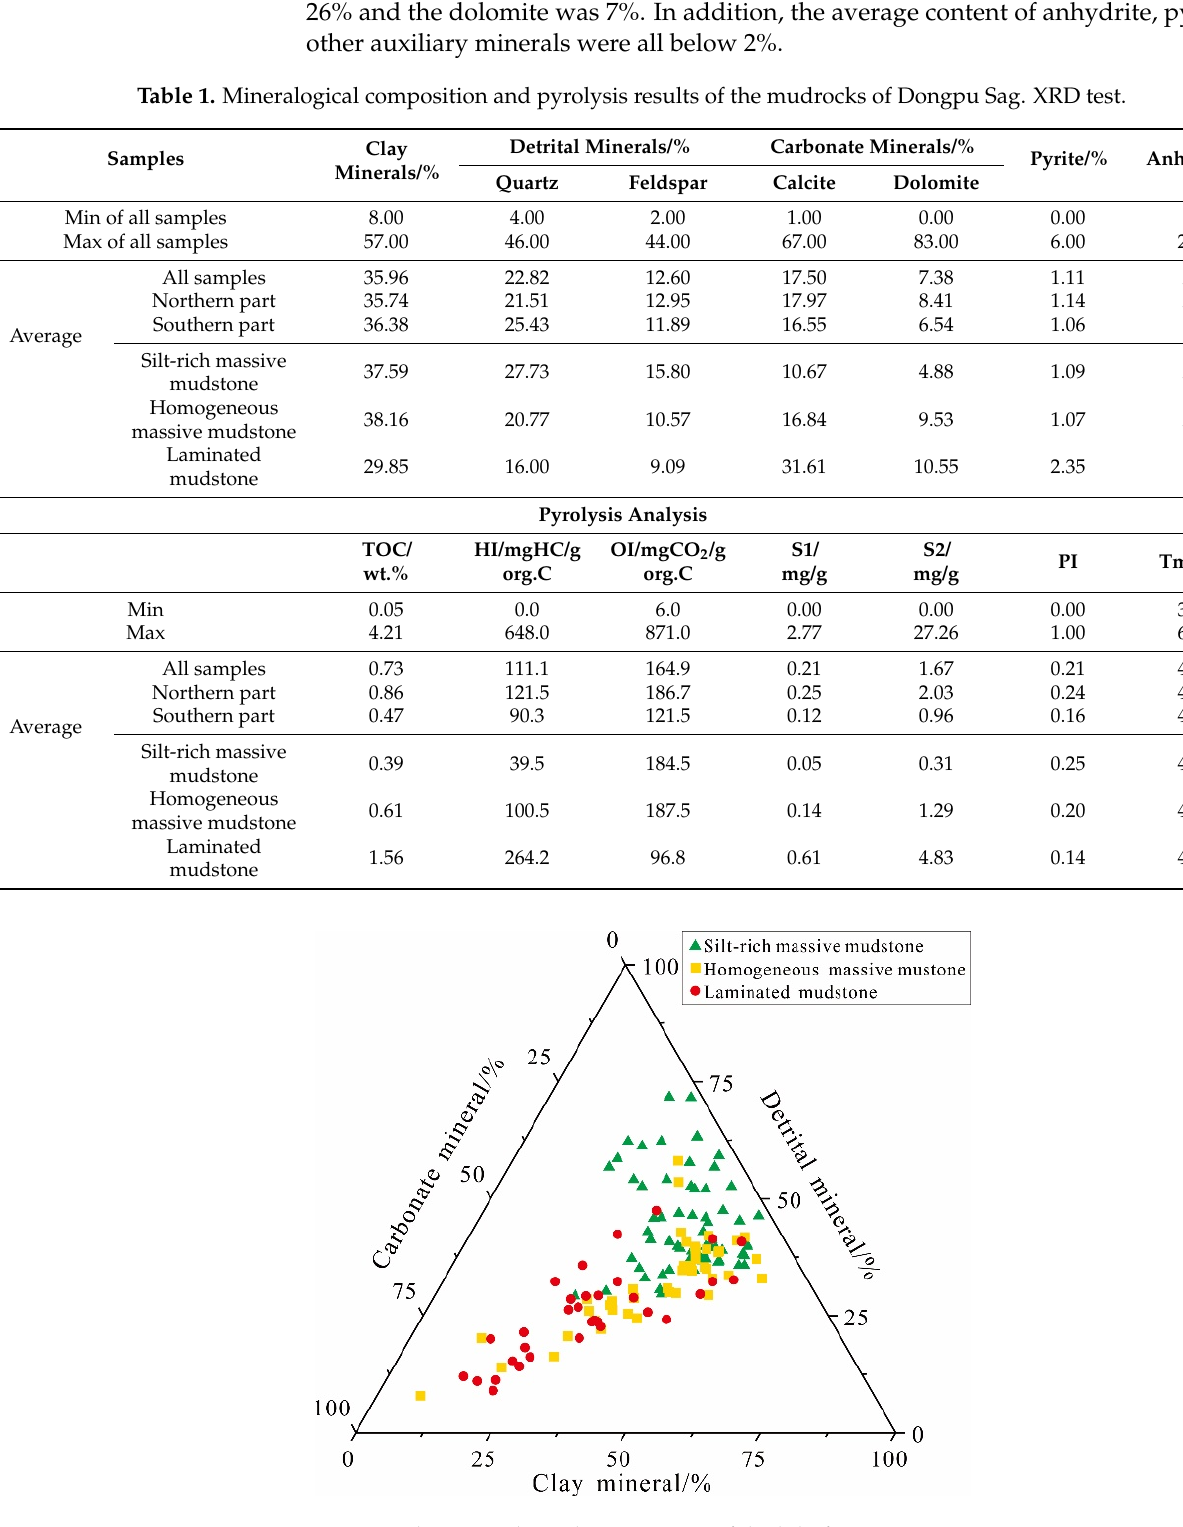
Figure 3. The mineralogical composition of the lithofacies.